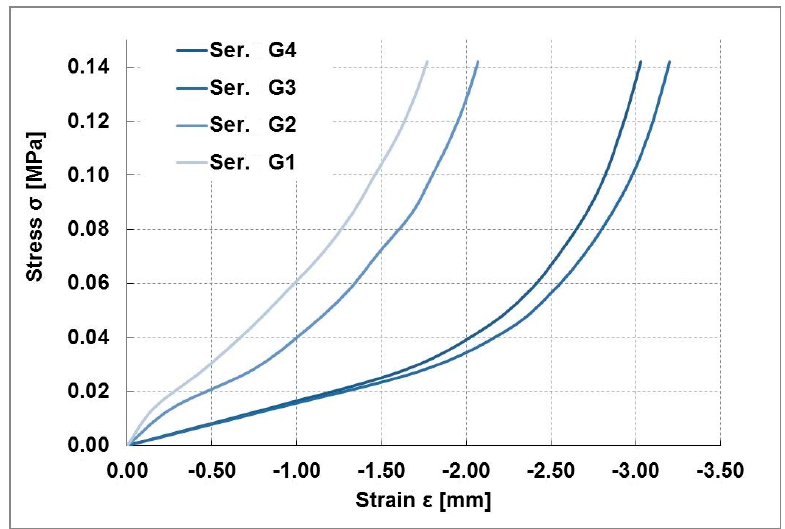
Figure 5. Compressive stress—strain curve for TPU/PLA/nHAp nanocomposite sponges: G1—TPU80/PLA20/nHAp10, G2—TPU/PLA/nHAp20, G3—TPU20/PLA80/nHAp10, and G4—TPU20/PLA80/nHAp20.